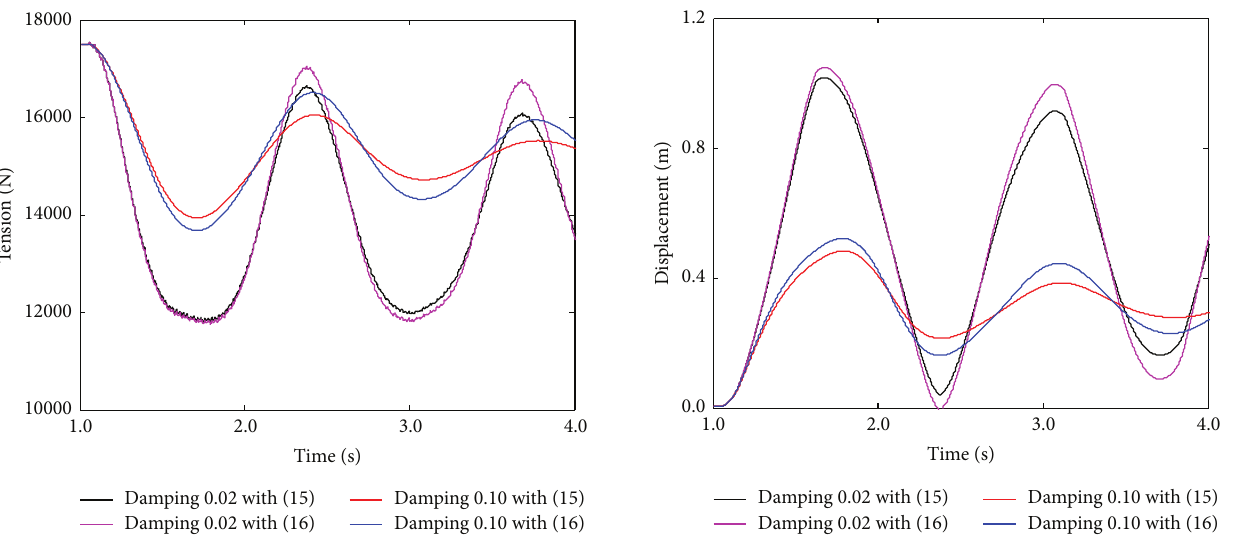
Figure 6: Comparison of cable tensions obtained with different damping models.